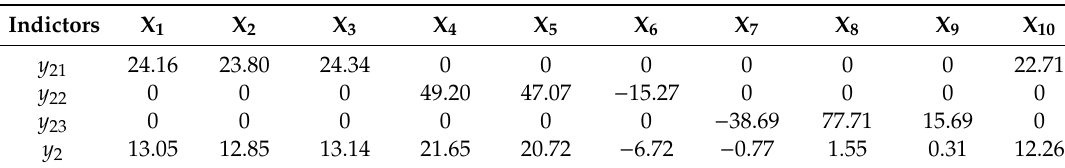
Table 10. Coe ffi cient of indictors.